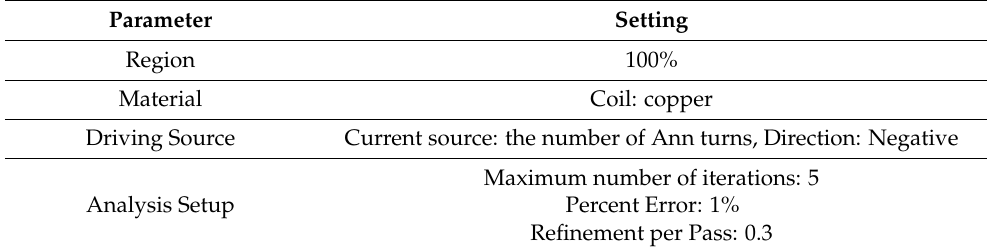
Figure 2. 3D model of different coils in the software: ( a ) Square coils; ( b ) Round coils. The simulation parameters are set as shown in Table 1. Table 1. Simulation parameters of the static magnetic field.